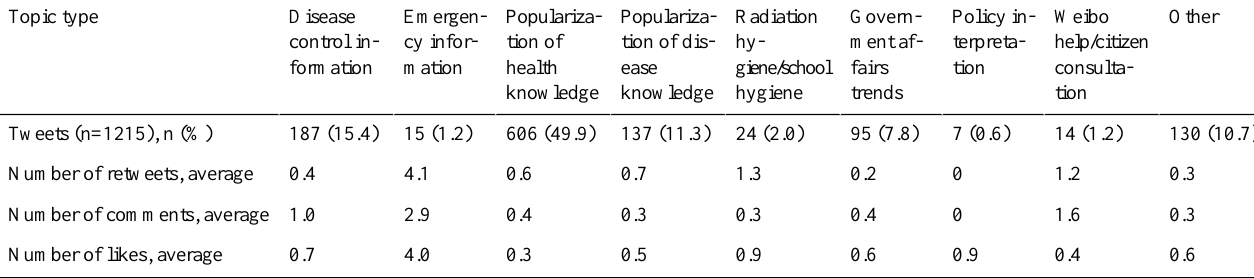
Table 3. Descriptive statistical analysis results based on the topic type of